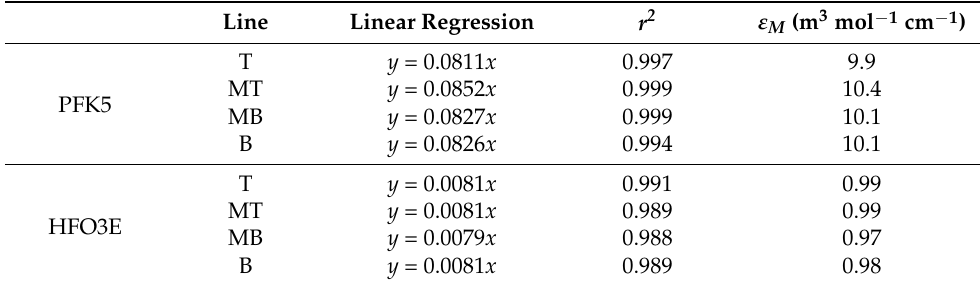
Table 4. Linear regression equations, correlation coefficients ( r 2 ), and molar absorptivities ( ε M ), of PFK5 and HFO3E.